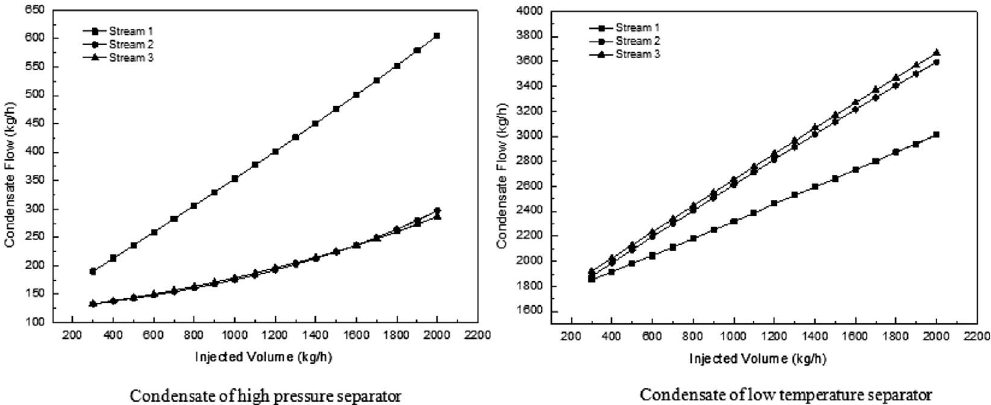
Fig. 10. The variation of condensate fl ow of high-pressure separator/low temperature separator with the injected volume.